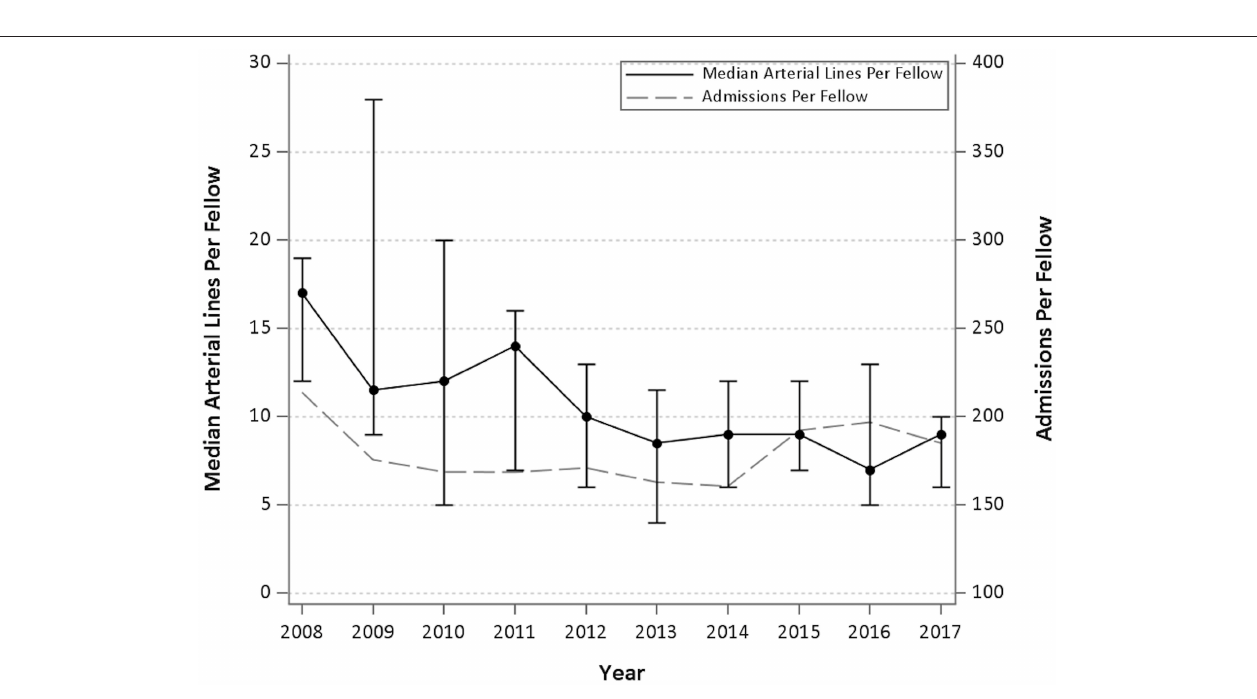
FIGURE 3 | Median and interquartile range of arterial lines per Fellow per year and admissions per Fellow year over 10